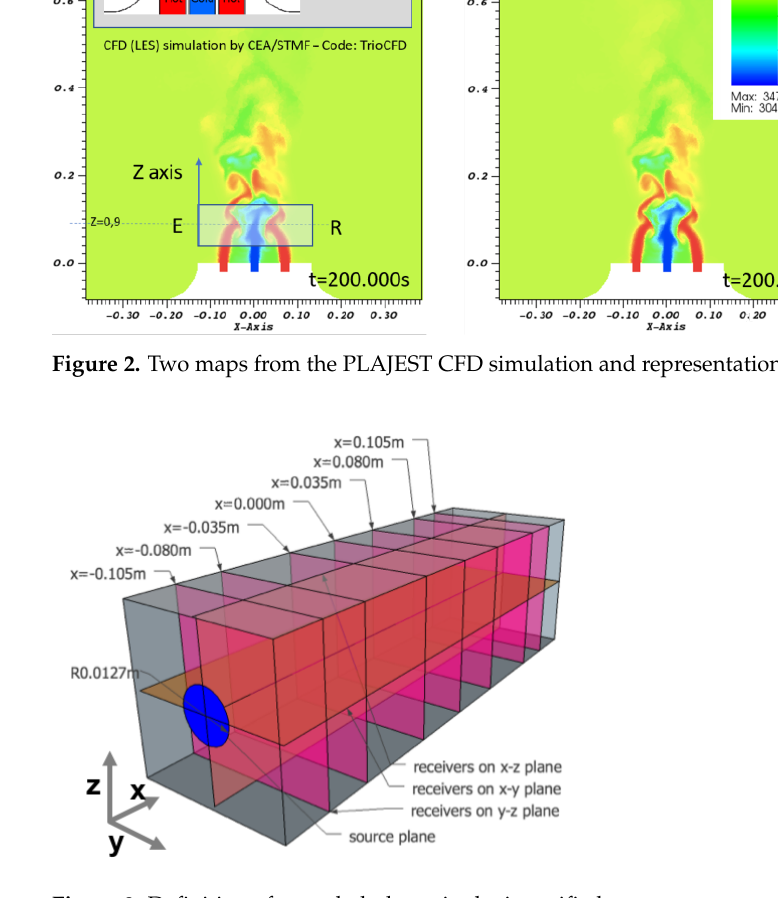
Figure 3. Definition of recorded planes in the insonified